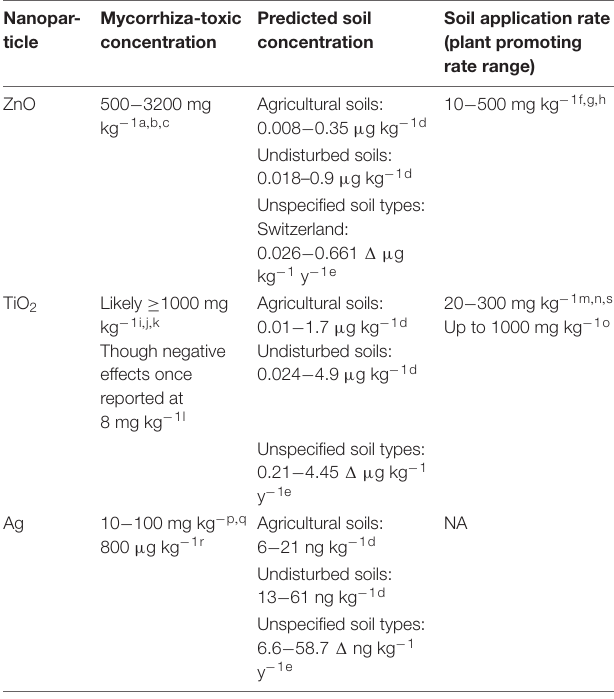
TABLE 3 | Mycorrhiza-toxic concentrations of nanoparticles vs. the predicted soil nanoparticles concentrations and/or plant-promoting soil application rates of nanoagrochemicals. Nanopar- Mycorrhiza-toxic ticle